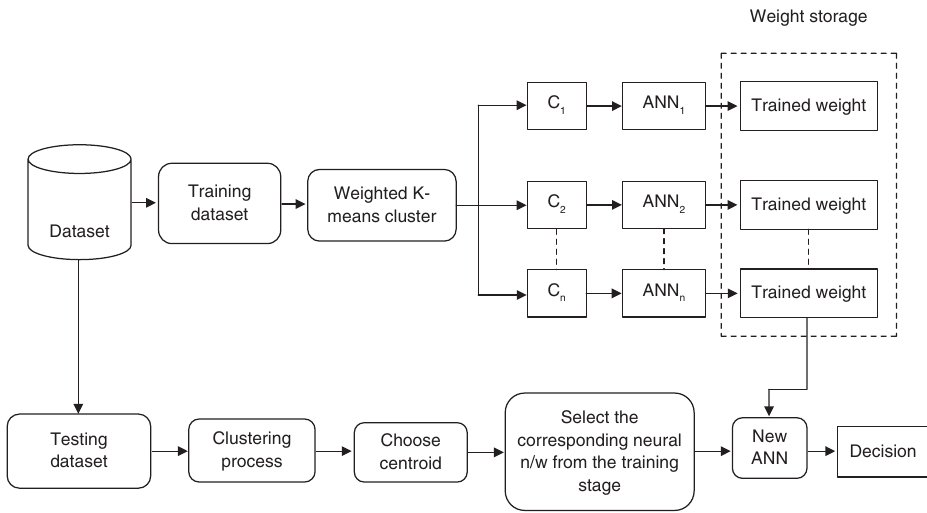
Figure 2: Overall Diagram of the Proposed Network Intrusion Detection